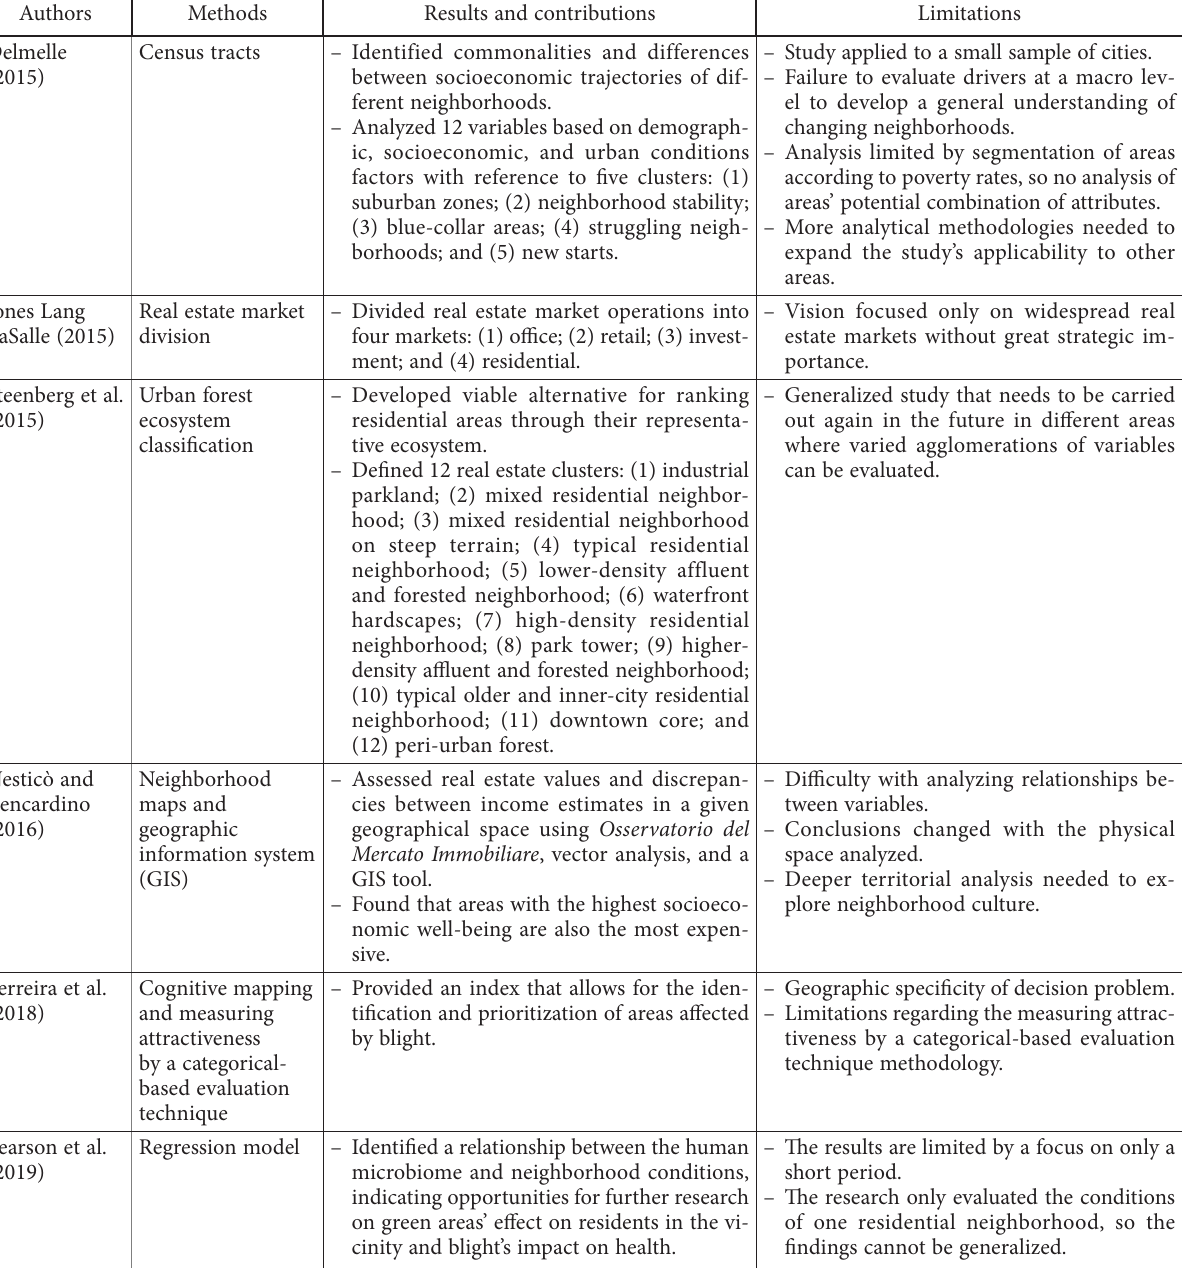
Table 1. Contributions and limitations of models for classifying residential